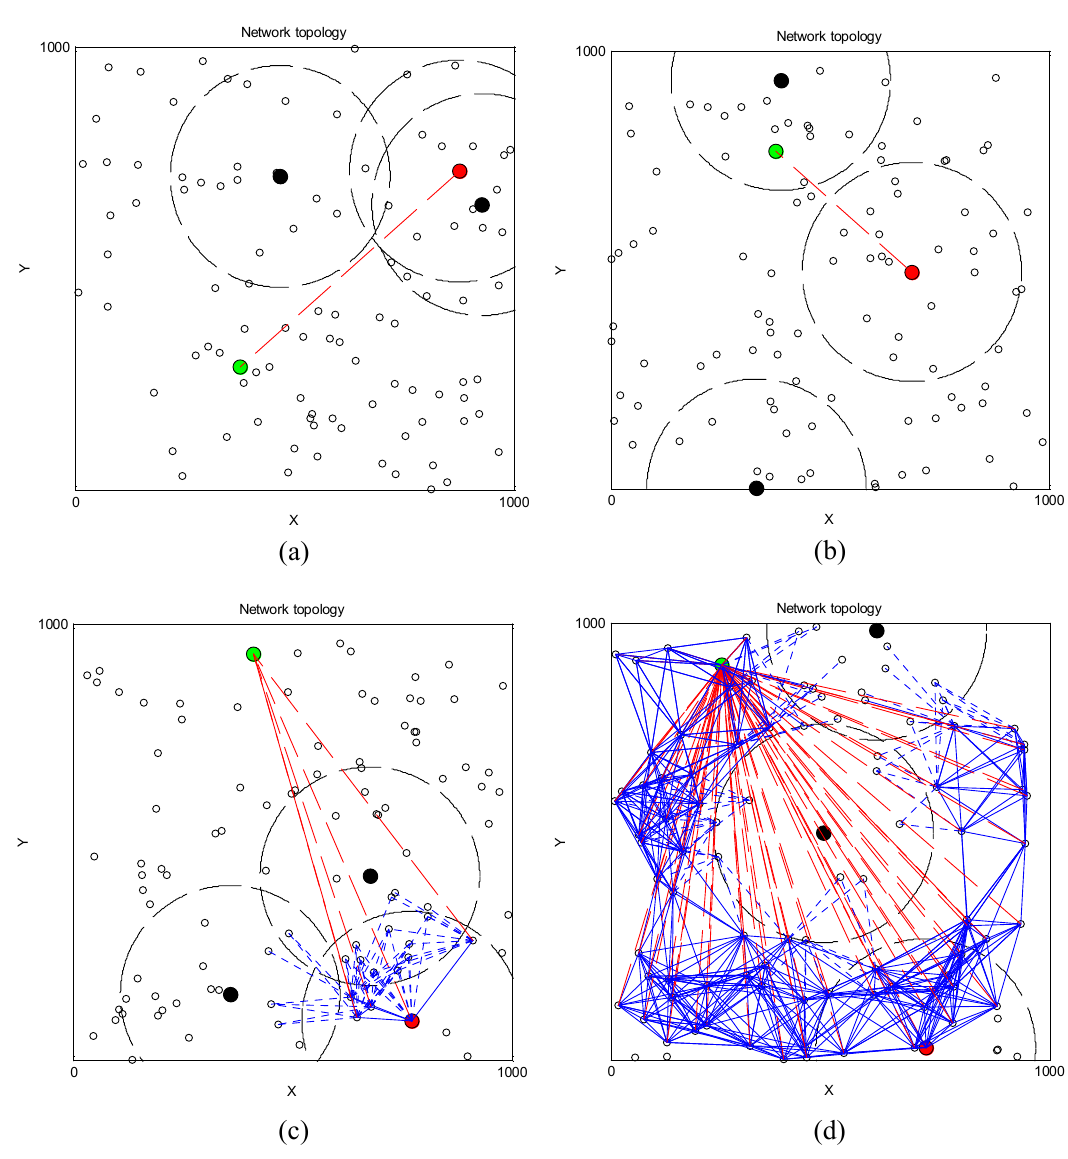
Figure 6. Illustrations of 4 over 50000 random network topologies used in simulation to evaluate the connectivity of multi-hop path between two arbitrary nodes in